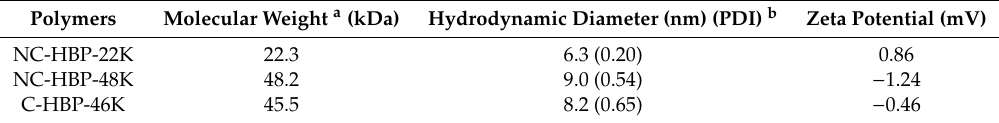
Table 1. Physicochemical properties of hyperbranched